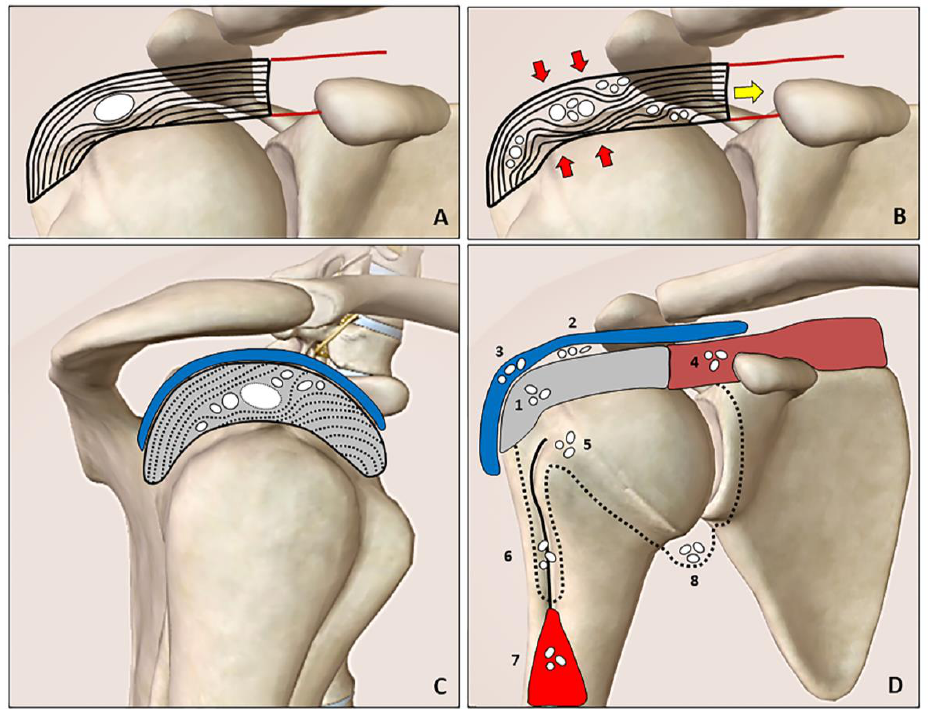
Figure 1. The resting phase is characterized by a hard calcification that shifts the tendon fibers ( A ). During the resorptive phase ( B ), the compression ( red arrows ) and tension ( yellow arrow ) forces promote slipping of the softly hydrated calcification through the layers/laminae of the tendon (rupture and dispersion of the calcific deposition). The intratendinous bursal-side (cranial direction) and articular side (caudal direction) migration patterns can be clearly identified during the US imaging by “following” the hyperechoic foci of the calcification ( white dots ) especially in the short axis view ( C ). Hydroxyapatite calcium crystals ( white dots ) can develop “migratory patterns”, i.e., moving from the rotator cuff tendons ( grey ) to several anatomical sites. The spectrum includes the following patterns: intratendinous (1) , sub-bursal ( 2 ), intrabursal ( 3 ), intramuscular ( 4 ), intraosseous ( 5 ), inside the synovial sheat of the long head of the biceps tendon (i.e., the bicipital recess) ( 6 ), between the interfascial planes of the arm ( 7 ) and perhaps inside the glenohumeral joint cavity ( 8 ) ( D ). Blue: subacromial bursa, brown: supraspinatus muscle, red: biceps brachii muscle, black line: long head of the biceps tendon, black dotted line: